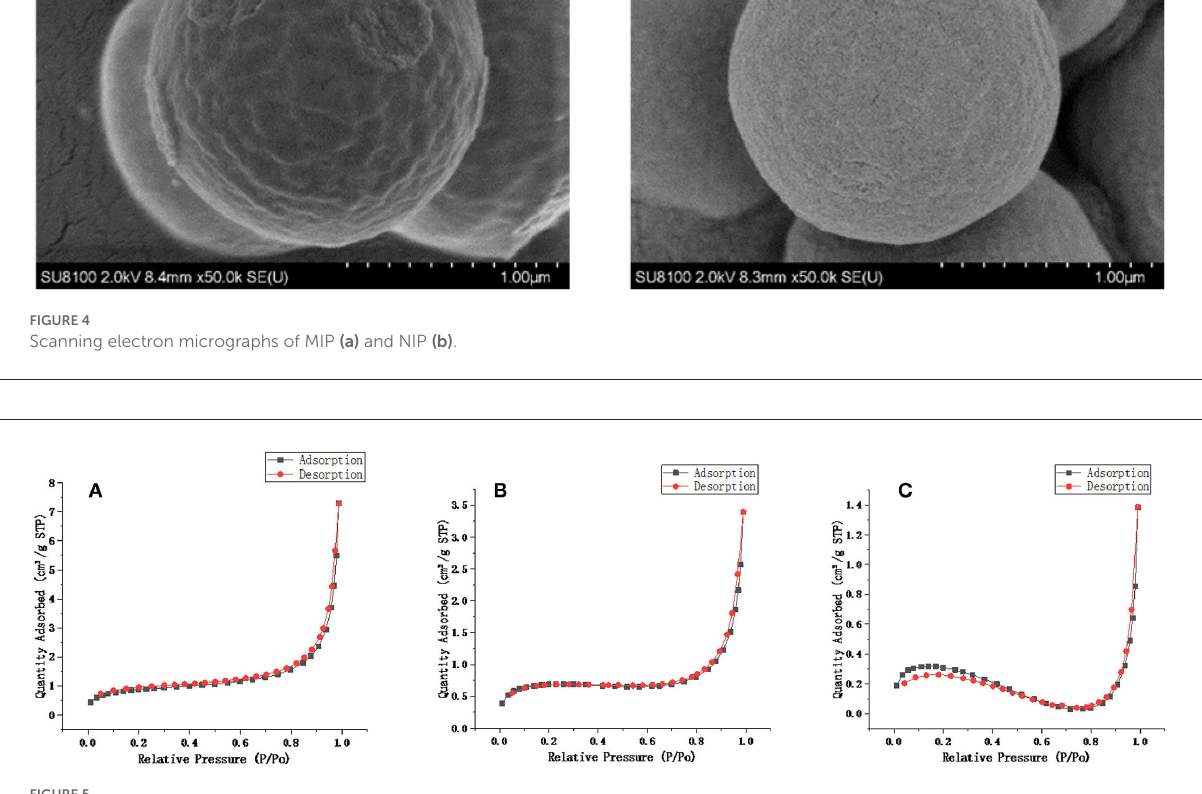
FIGURE5 Linear isotherm plot of (A) washed MIP. (B) Unwashed MIP. (C)